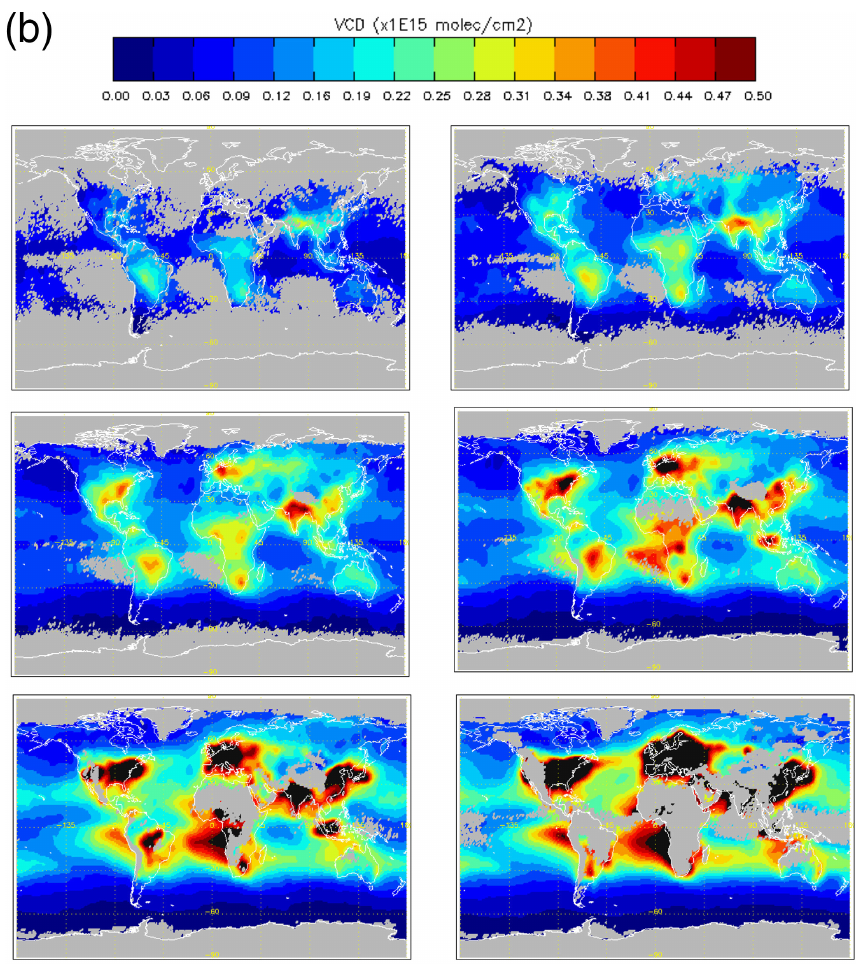
Figure 3. (a) OMI NO 2 VCDs above cloud – average quantities for the year 2006: for high-altitude clouds (top row, 330 and 450hPa), mid- altitude clouds (middle row, 570 and 670hPa) and low clouds (bottom row, 770 and 870hPa). Gray means no data available (i.e., insufficient number of cloud detections in the cell). (b) Same as (a) but for TM4.